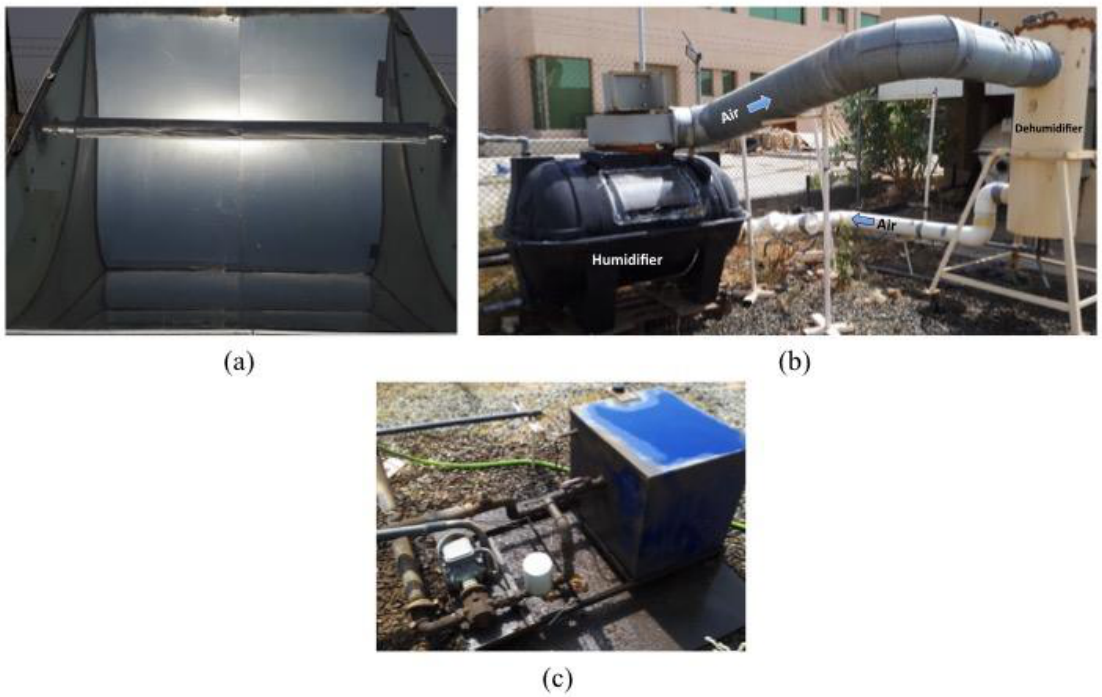
Figure 3. Photos of the experimental setup and main components: ( a ) parabolic trough collector (PTC) with absorber tube; ( b ) humidification and dehumidification (HDH) desalination unit; and ( c ) oil expansion tank.